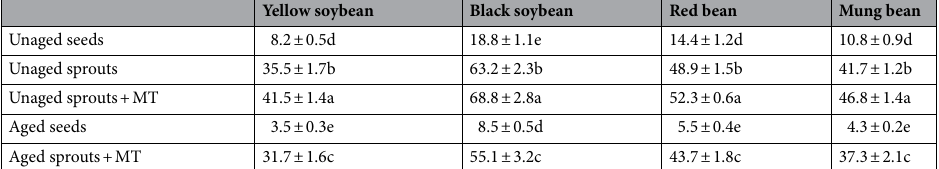
Table 2. Ferric reducing power. Ferric reducing power (mmol Fe 2+ g −1 dry weight) was measured in control and aged bean seeds and sprouts germinated from melatonin-treated aged seeds. Means with the same column (n = 3) followed by the same letter are not significantly different ( p < 0.05). “(un)aged sprout” refers the germinated seed and sprouts produced from (un)aged seed. MT melatonin.